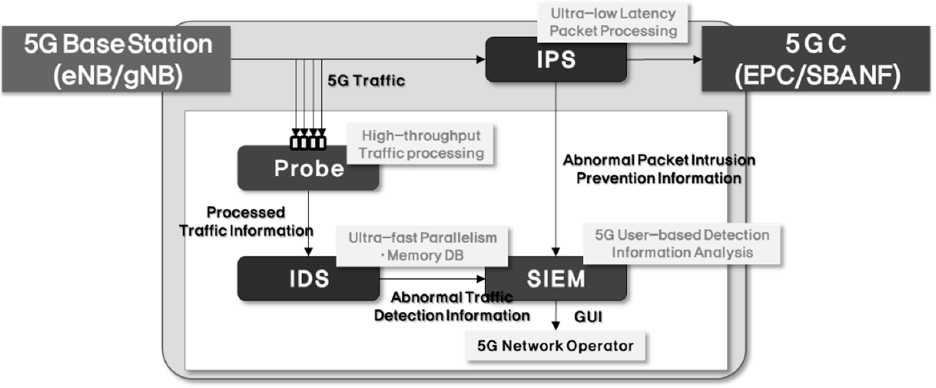
Figure 12. System architecture for 5G security threat countermeasure.